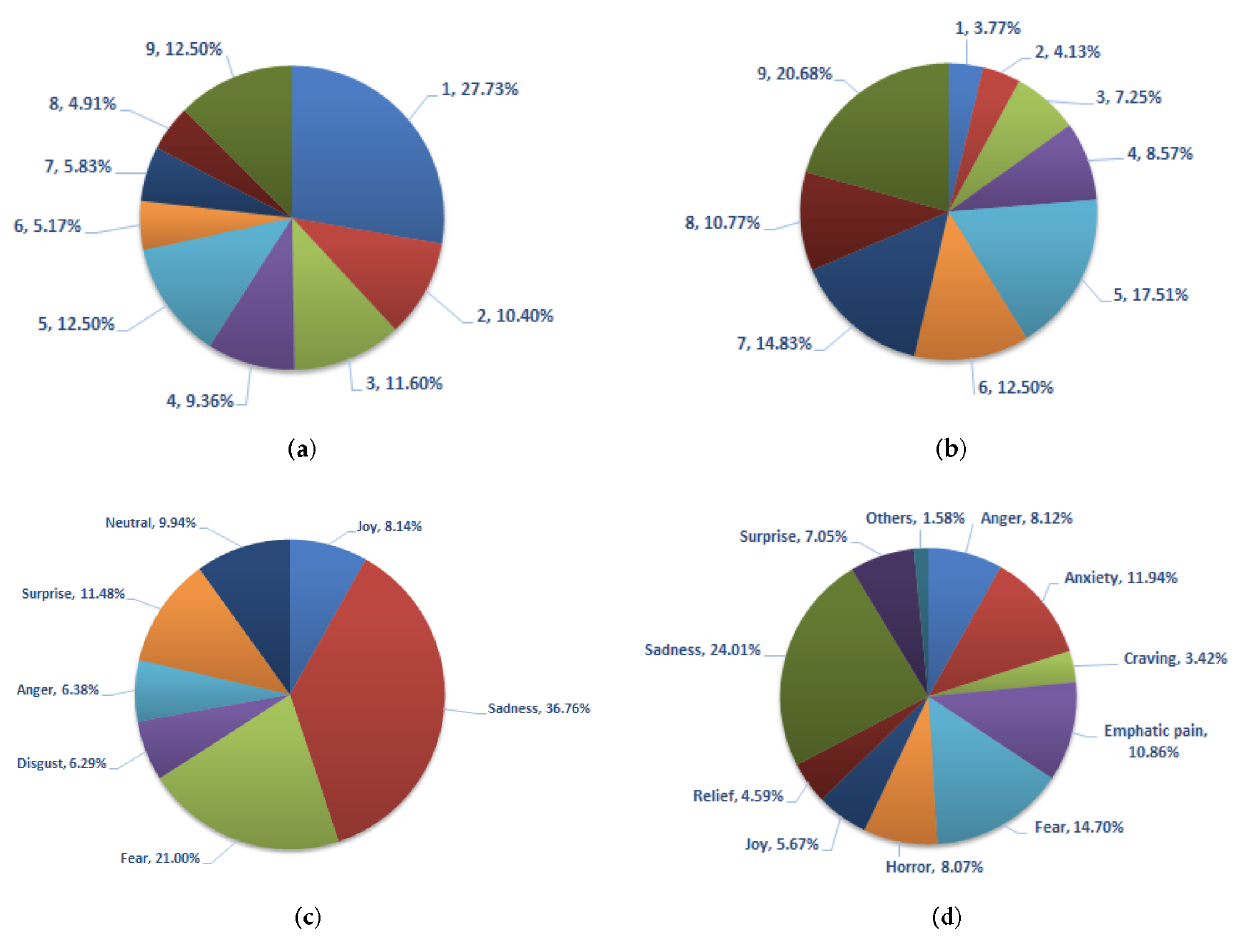
Figure 6. Statistics of the first four questions of the crowd-sourcing study. ( a ) Statistics of the responses for the first question. Tags 1 to 4 represent negative sentiments while tag 5 represents neutral, and tags 6 to 9 show positive sentiments. ( b ) Statistics of the responses for the second question. Tags 1 to 4 represent calm/relaxed emotion, tag 5 shows a normal condition, while tags 6 to 9 depict excited/stimulated status. ( c ) Statistics of the responses for the third question. ( d ) Statistics of the responses for the fourth